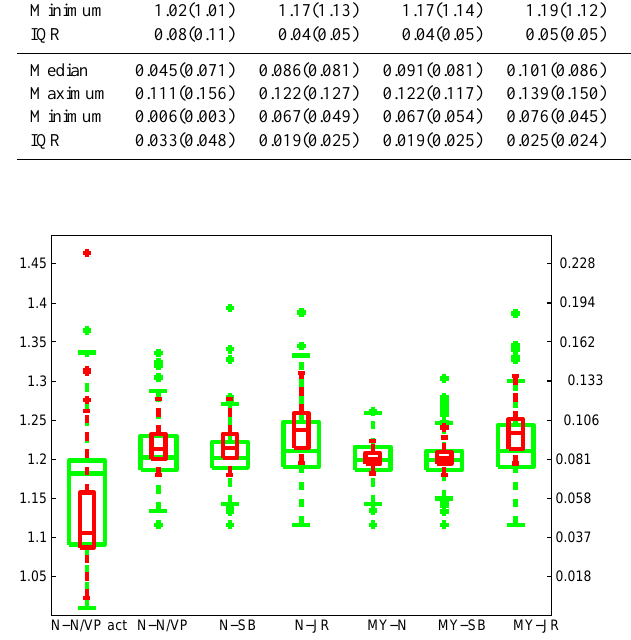
Fig. 2. Predicted growth factors as a function of predictive tech- nique and number of compounds used in the partitioning calcula- tions, assuming the only difference between the wet and dry sizes is that of the equilibrium water content. 10000 compound simu- lations are shown as red boxes, 2 compound simulations as green. Predictive technique acronyms displayed on the x-axis are listed in Table 1. The left-hand y-axis lists calculated GF D , the right side lists the corresponding κ